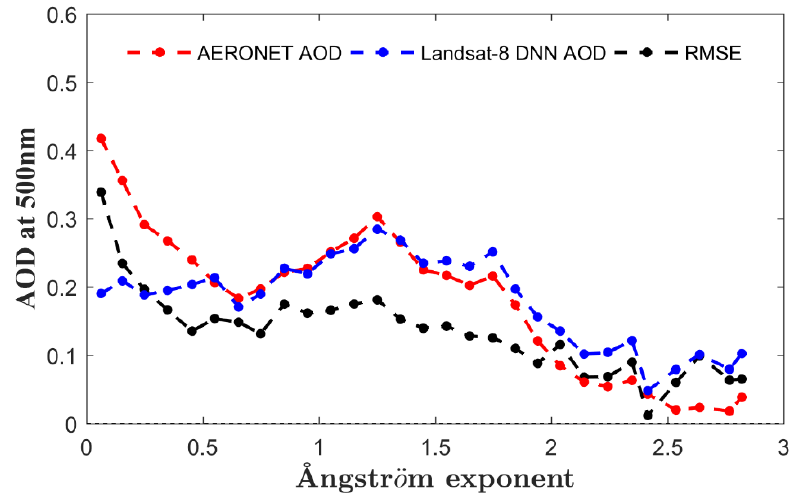
Figure 7. RMSE in DNN-estimated AOD as a function of Ångström exponent. AERONET AOD, Landsat-8 DNN AOD, and their RMSE are shown in red, blue and black dotted lines, respectively.